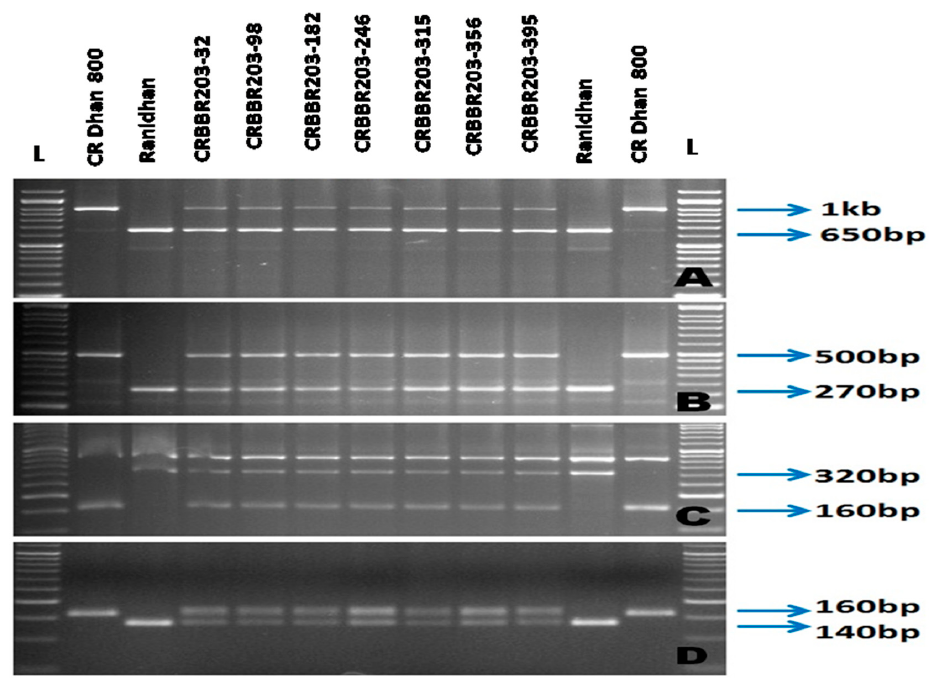
Figure 3. Electropherogram of BC 2 F 1 derivatives of rice variety, Ranidhan for four BB resistance genes Xa21, xa13 , xa5 and Xa4 using markers ( A ) pTA248; ( B ) Xa-13 prom; ( C ) xa5S/R (Multiplex); Figure 3 ( D ) MP-Nbp-131. Lane 1, 13: 50 bp ladder; Lane 2, 12: CR Dhan 800; Lane 3, 11: Ranidhan; Lane 4–10: BC 2 F 1 derivatives of rice variety,